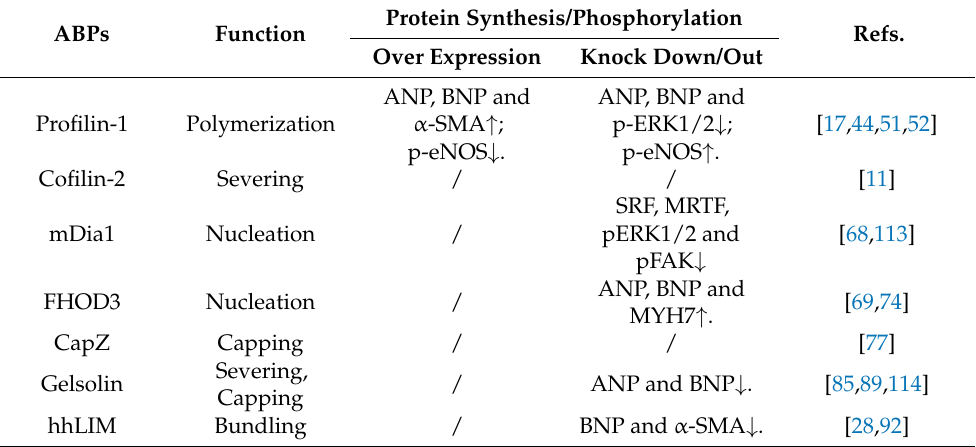
Table 2. Inductive cues for cardiac